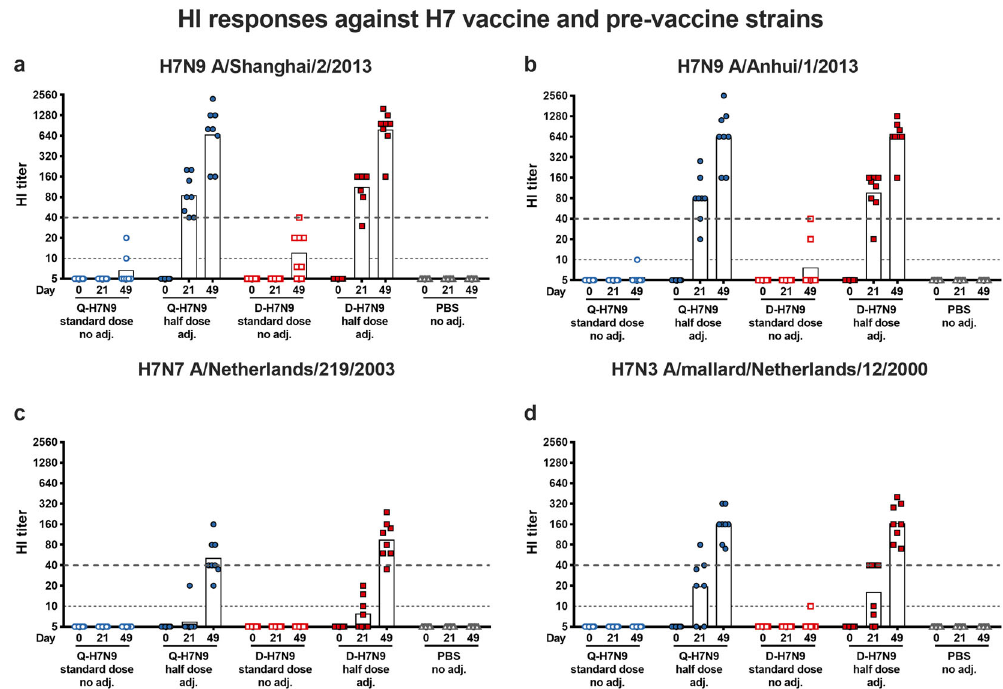
Fig. 2 Hemagglutination inhibition (HI) titers against homologous H7N9 viruses and heterologous H7N3 and H7N7 viruses. HI titers against H7N9 A/Shanghai/2/2013 ( a ), H7N9 A/Anhui/1/2013 ( b ), H7N7 A/Netherlands/219/2003 ( c ), and H7N3 A/mallard/Netherlands/12/2000 ( d ) are shown on the y -axis. The dashed gray line indicates an HI titer of 1:40. The x -axis shows the timepoints (day 0, 21, 49) and the treatment groups are indicated. The dashed gray line at an HI titer of 1:10 represents the limit of detection.